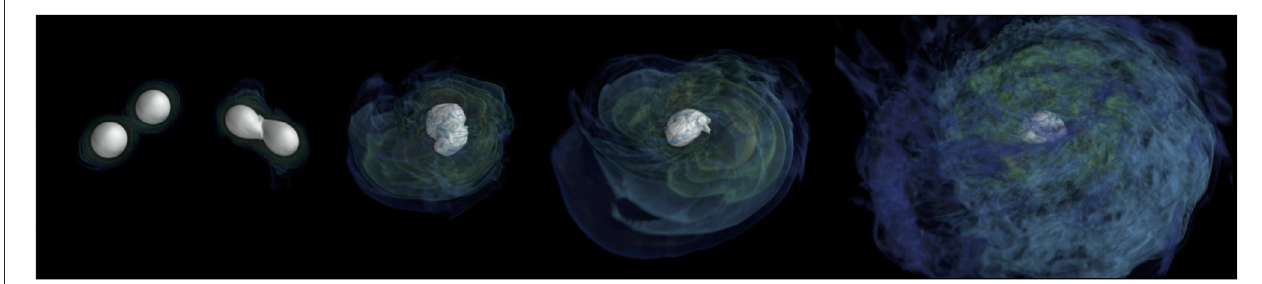
FIGURE 1 | Example of BNS merger simulation in GRMHD (from the models presented in Ciolfi et al., 2017). The temporal sequence shows the bulk of the NS(s) in white together with color-coded isodensity surfaces.